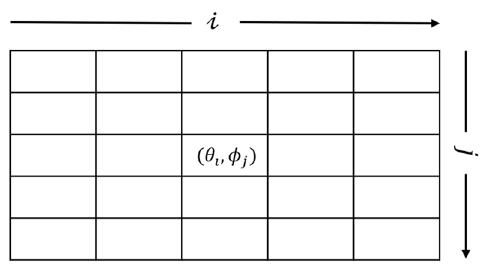
Figure 22. Network architecture.